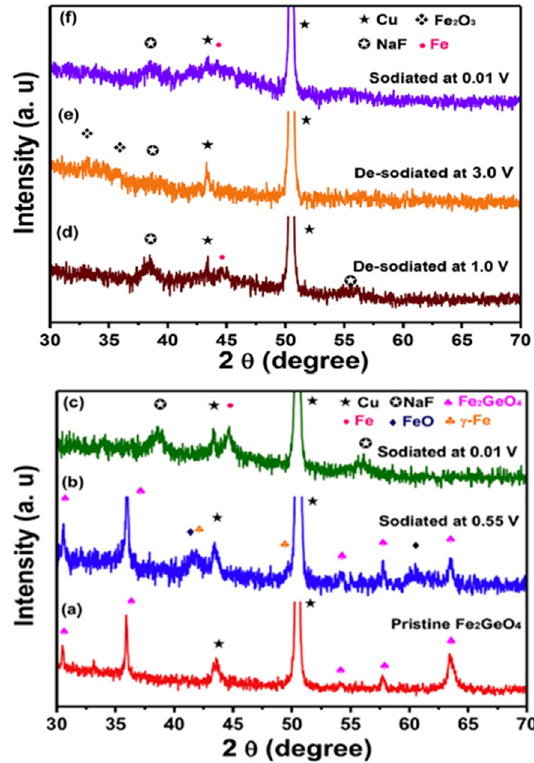
Figure 10. Ex-Situ XRD patterns of GFO electrode at different states of charge: (a) pristine electrode, (b) sodiated at 0.55 V, (c) sodiated at 0.01 V, (d) de-sodiated at 1.0 V, (e) de-sodiated at 3.0 V, and (f) sodiated at 0.01 V [28]. Reproduced with permission, Copyright Elsevier 2019.